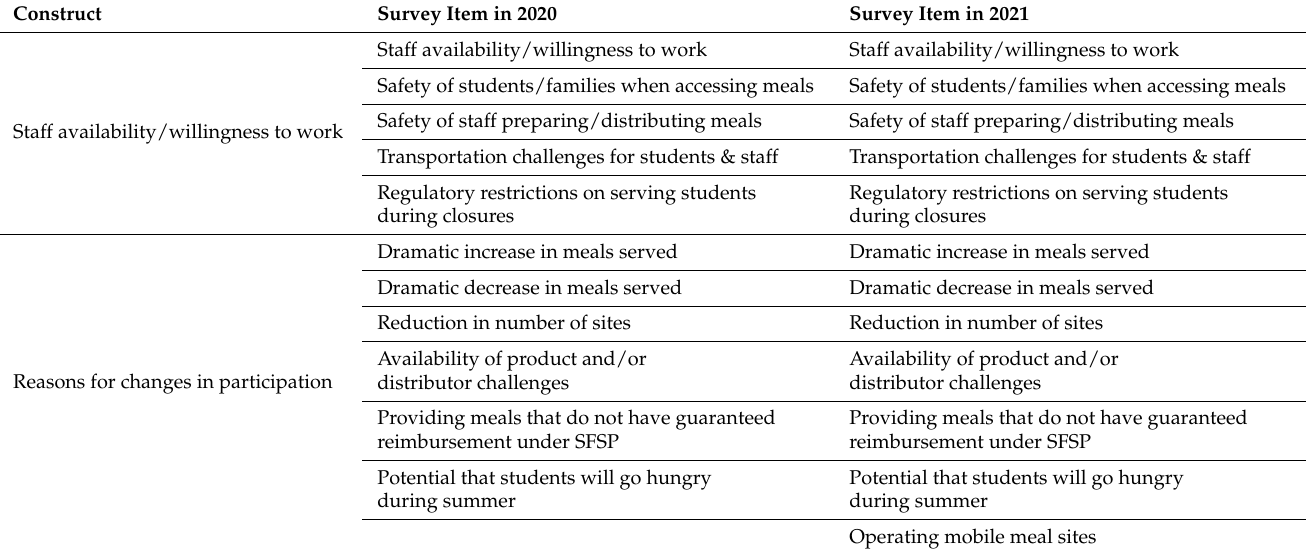
Table A2. 2020 and 2021 survey items regarding concerns due to the COVID-19